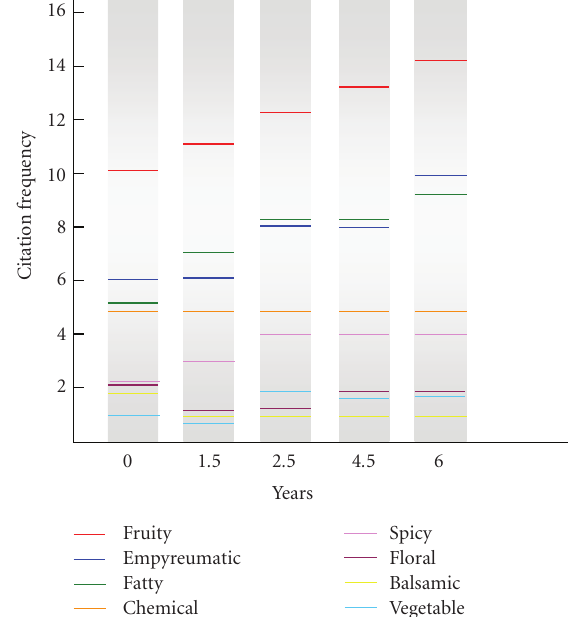
Figure 1: Aroma fingerprint for sherry type wine during the biological